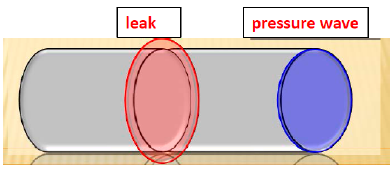
Figure 1. Displaying leakage and pressure wave.